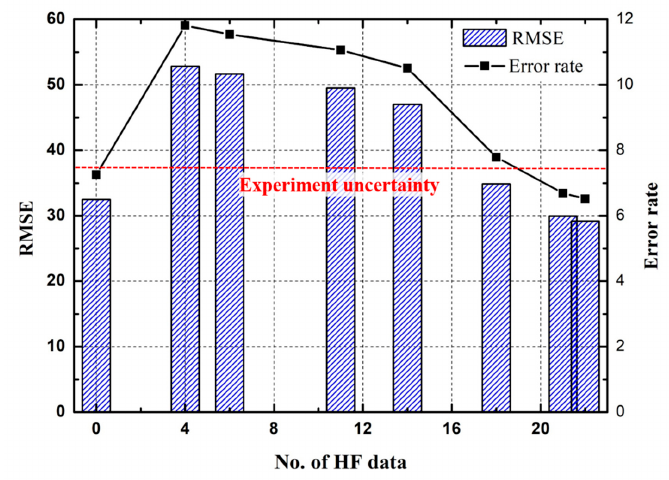
Figure 12. Root-mean-square error (RMSE) and error rate in each MFS.